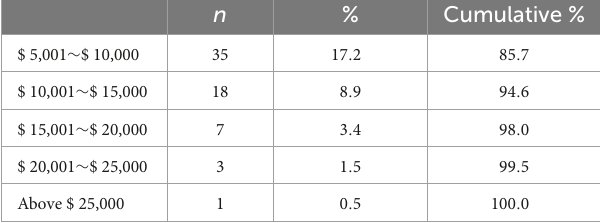
TABLE 1 Descriptive statistics of sample demographic